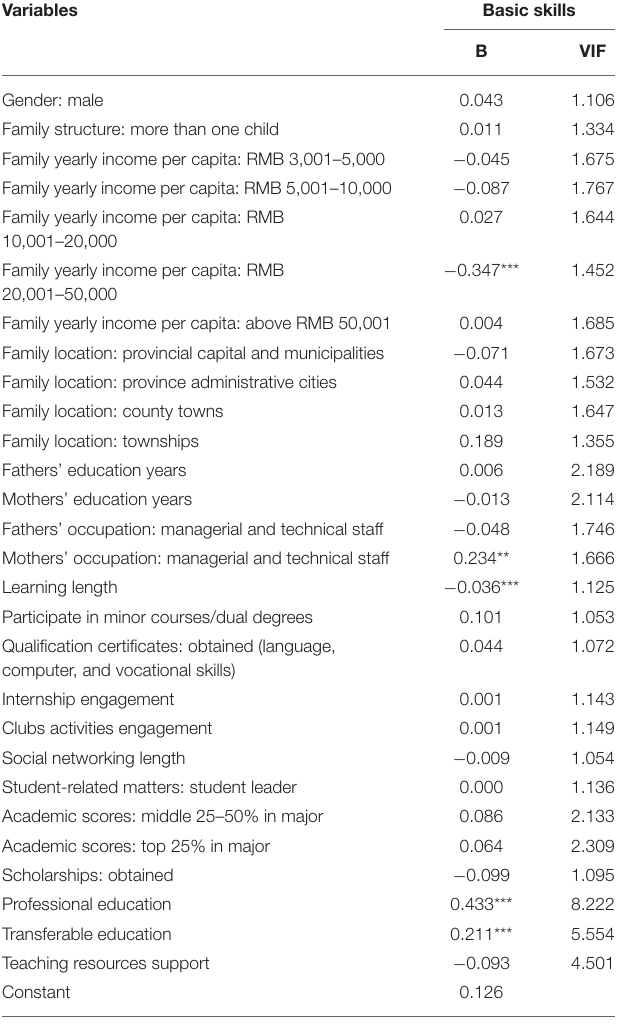
TABLE 7 | Factors impact on finance and trade graduates’ basic skills.